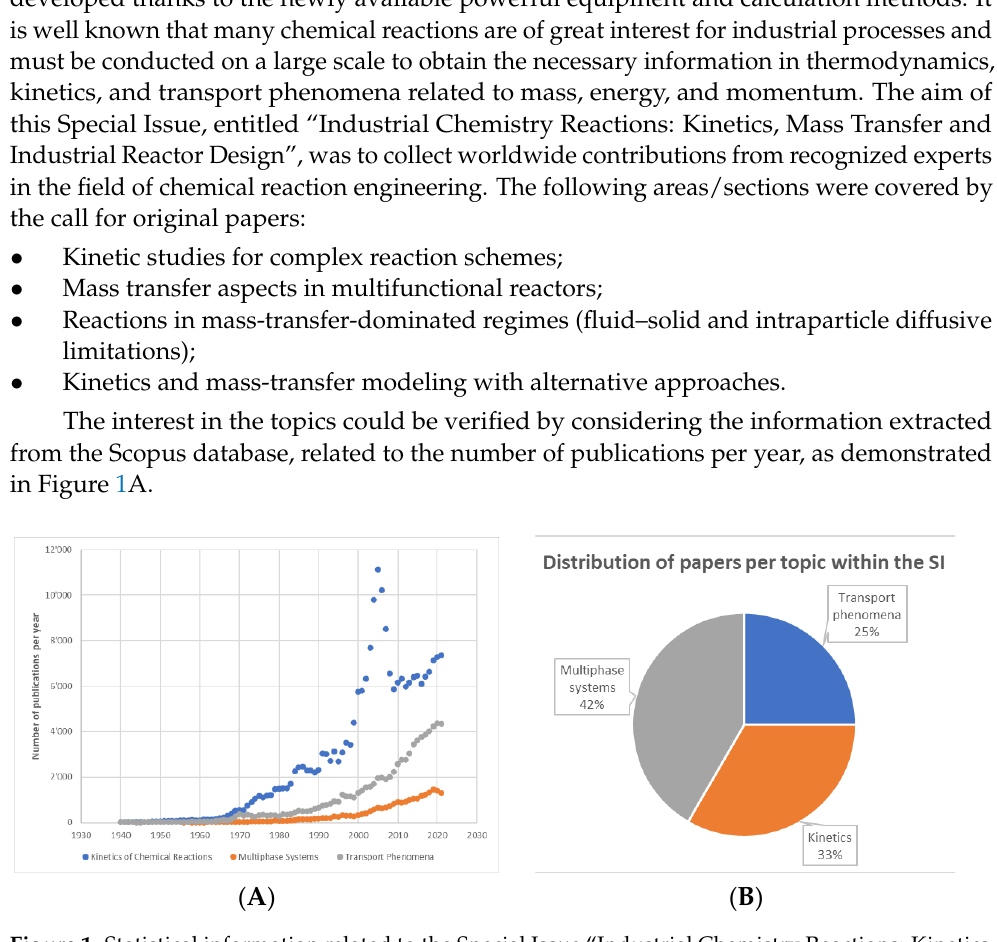
( A ) ( B ) Figure 2. Parity plots for: ( A ) epoxidized soybean oil ring opening tests in the presence of sulfuric acid as catalyst [2]; ( B ) hydrogenation of trans, trans-muconic acid to bio-adipic acid promoted by Pd/C 5% (wt) [4]. Three articles of the Special Issue were devoted to problems of transport phenomena. First of all, Tesser and Santacesaria [5] published a brief review on the role of mass and heat transfer in gas – solid catalytic reactions, updating the knowledge on this topic by con- sidering the considerable progress in computing power has occurred in the last 20 years. This progress has favored the use of numerical methods in the simulation of complex sys- tems involving kinetics and mass transfer, as in gas – solid catalytic reactions, starting from a generic treatment of the multiphase system (see the sketch in Figure 3A). Somchart Chantasiriwan [6] published a study on sugar juice evaporation, aiming to increase the